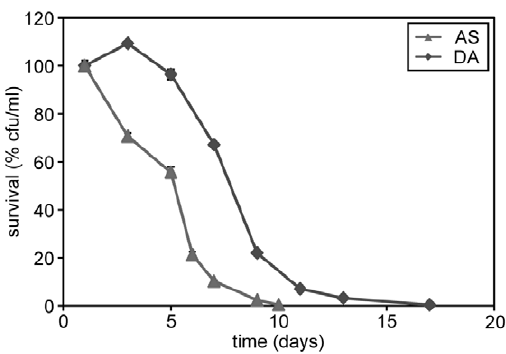
Figure 9. Chronological aging of H.polymorpha cells grown on D-alanine. CLS of wild-type cells following cultivation on 0.5% methanol in the presence of 0.25% AS or 0.33% D-alanine (DA) as sole nitrogen sources. The lifespan curves shown represent the average of 4–6 experiments.